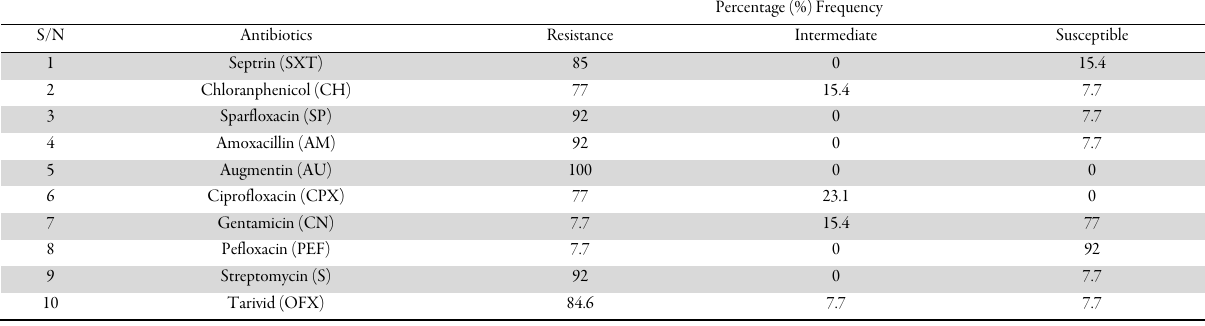
Table 3b. Percentage frequency of antibiotic susceptibility pattern for gram negative bacterial